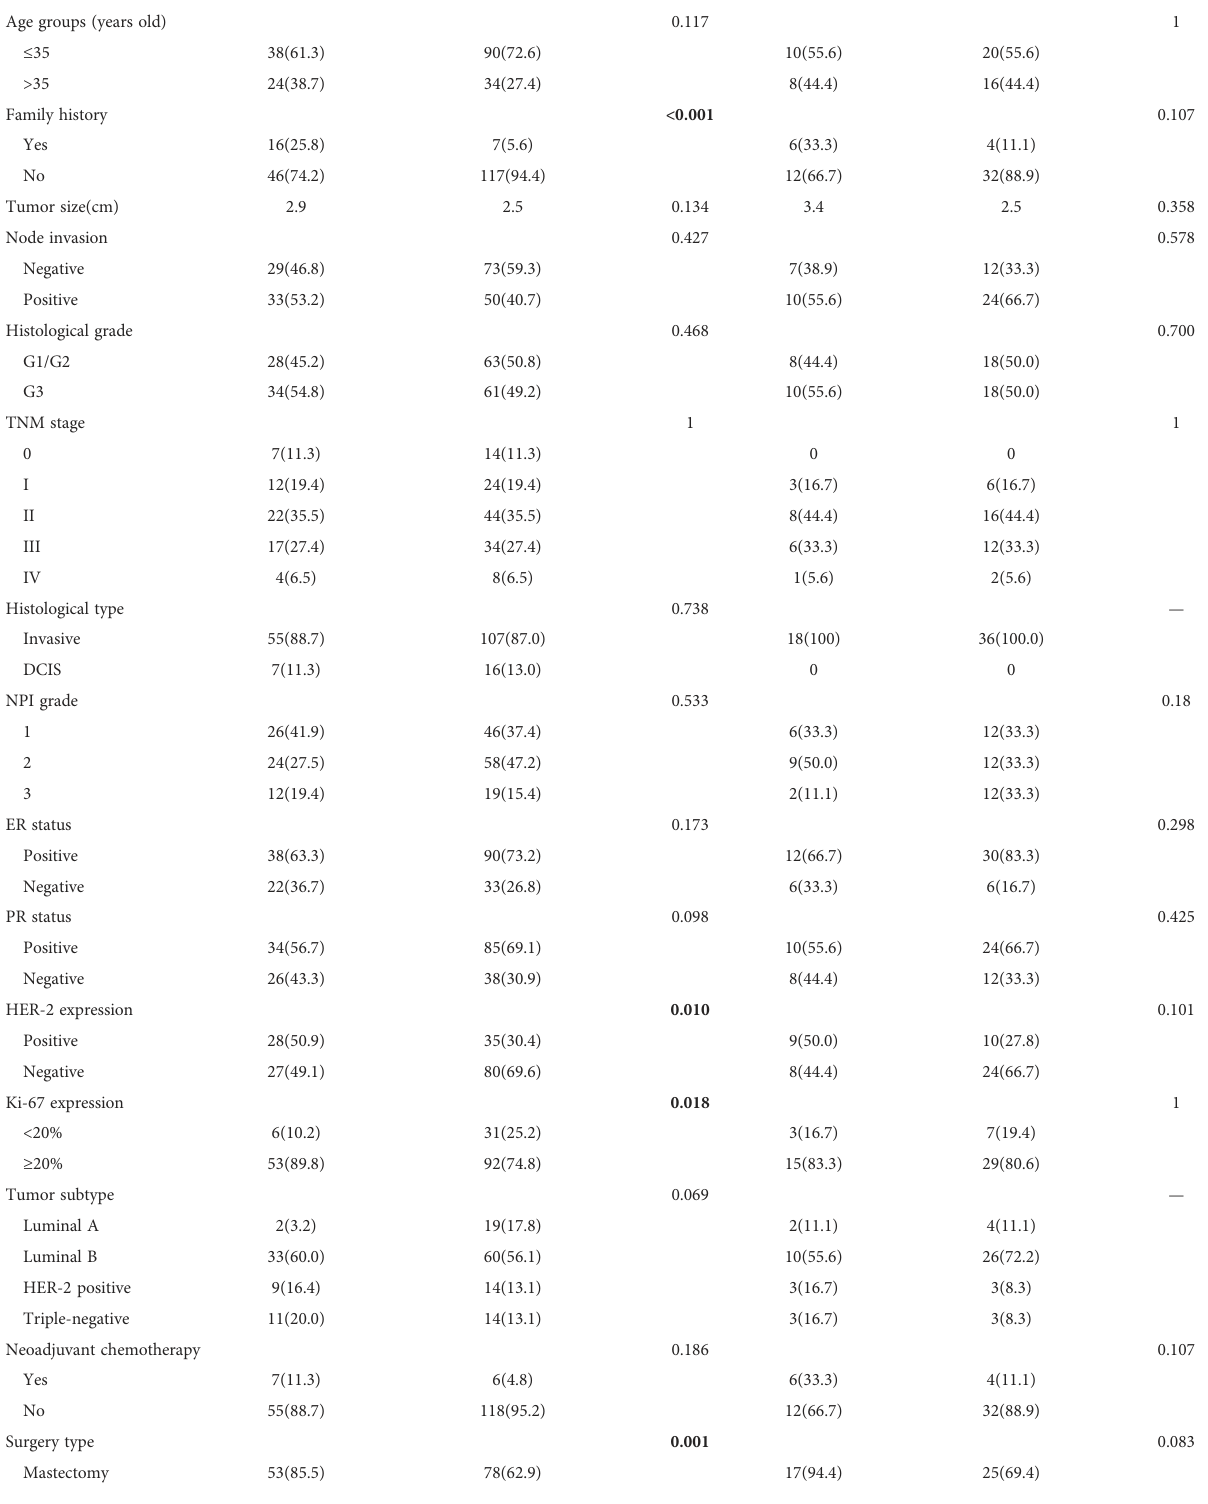
TABLE 1 Clinicopathological features and treatment of PABC patients.